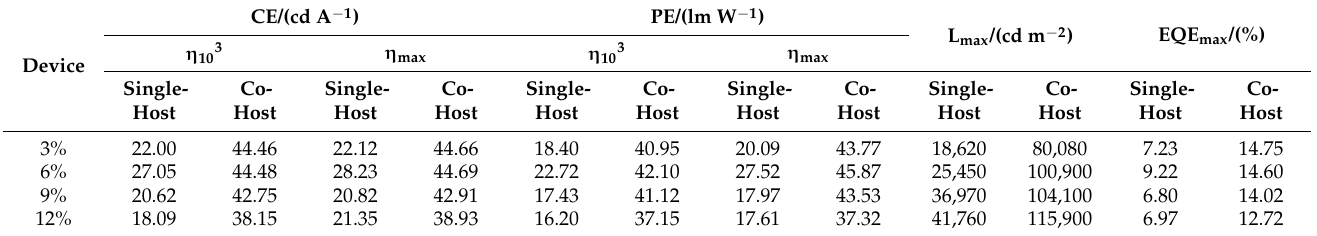
Table 1. The key electroluminescent (EL)performances of the co-host and reference devices.